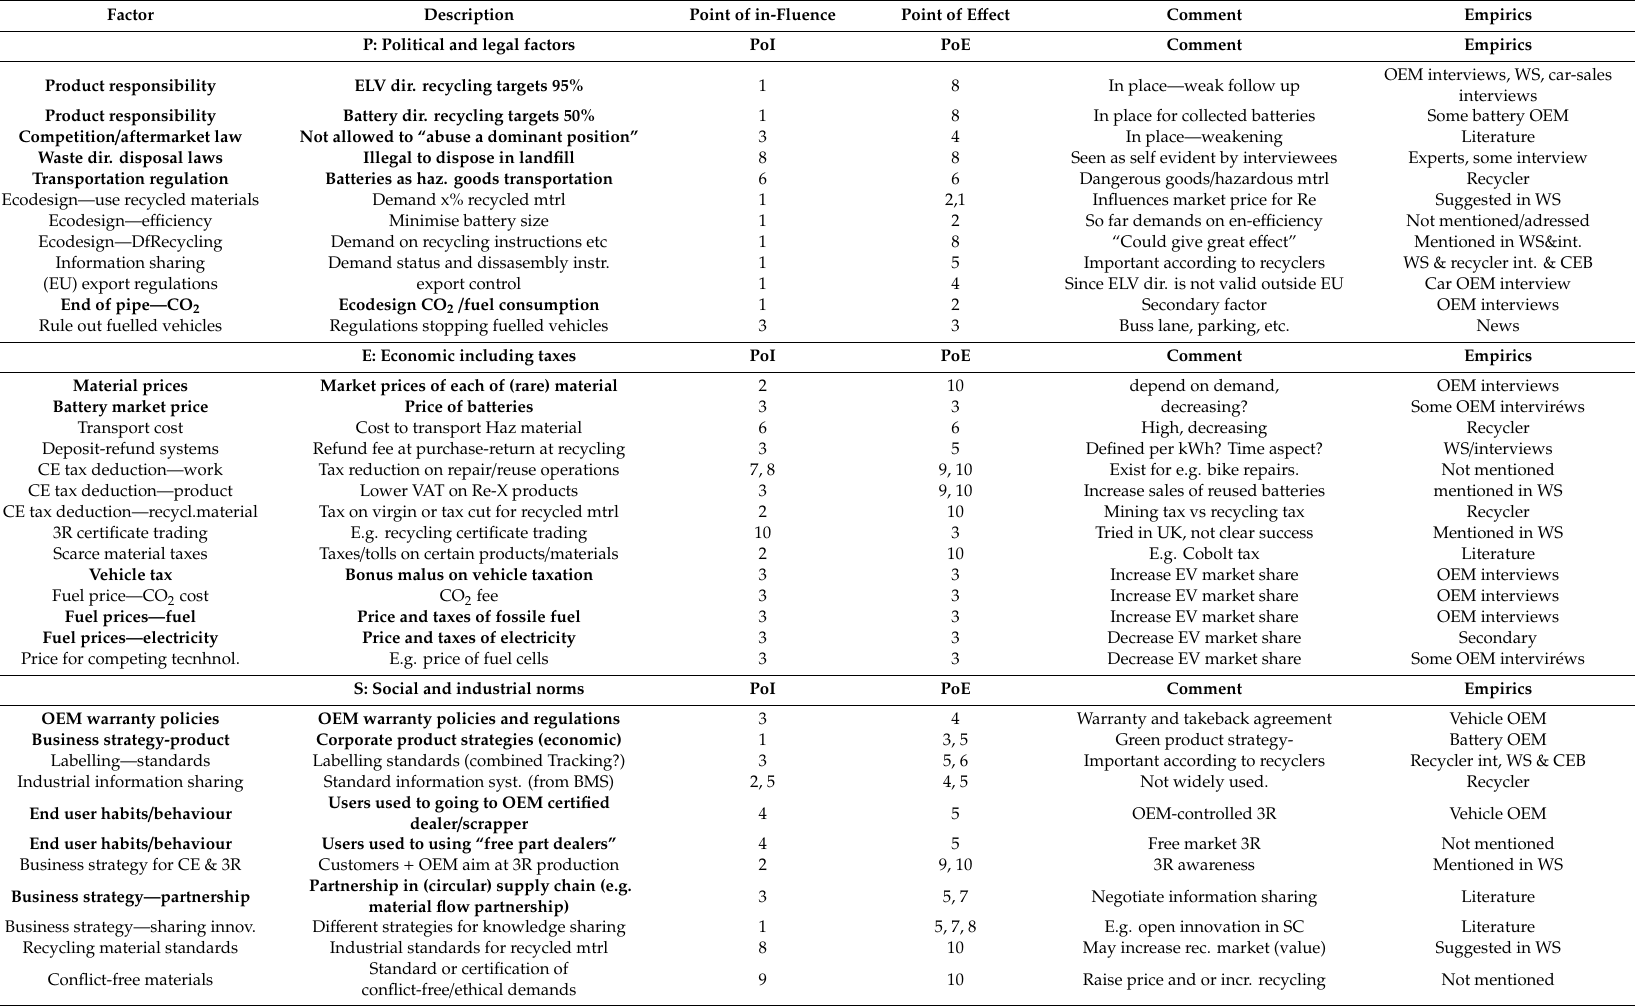
Table A1. PEST analysis (political, economic, social and technological